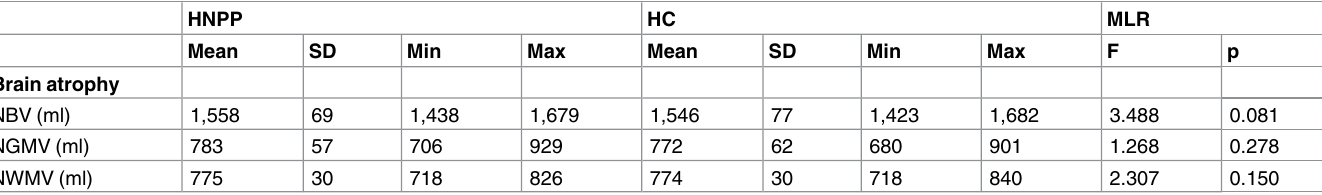
Abbreviations: HC, healthy controls; MLR, multiple linear regression; SD, standard deviation; NBV, normalized brain volume; NGMV, normalized grey matter volume; NWMV, normalized white matter